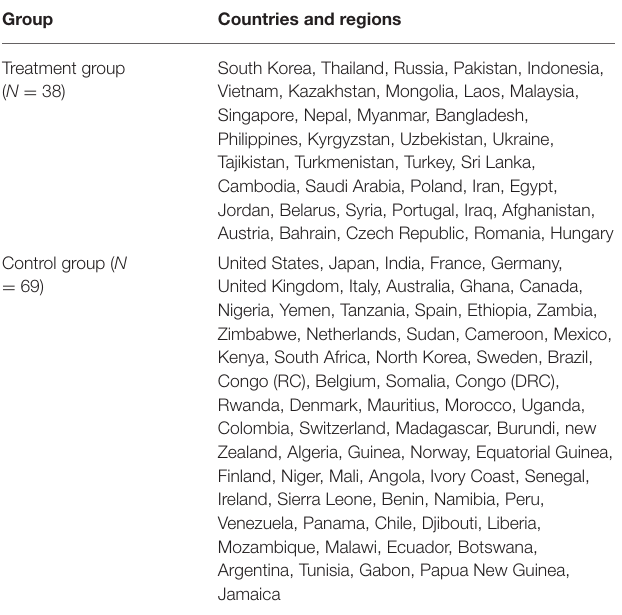
TABLE 3 | Samples of treatment group and control group.